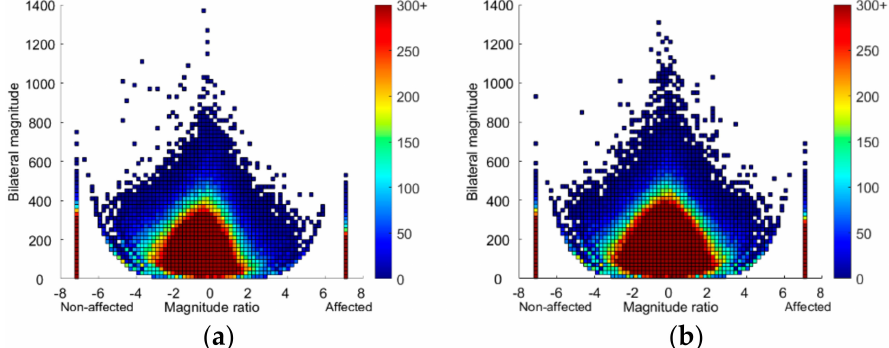
Figure 3. Density plots showing 24 h of upper limb activity in the ( a ) mismatch group ( n = 15; Fugl-Meyer Assessment upper extremity FMA-UE >50, hand domain of the Stroke Impact Scale SIS-Hand ≤ 75) and ( b ) good match group ( n = 16; FMA-UE >50, SIS-Hand >75) plotted on a second- by-second basis. The magnitude ratio (x-axis) indicates contribution of each limb to activity. The bilateral magnitude (y-axis) indicates the activity intensity. The color represents frequency, with brighter colors indicating greater frequencies. Bars at − 7 and 7 show unilateral unaffected and affected UL activity,